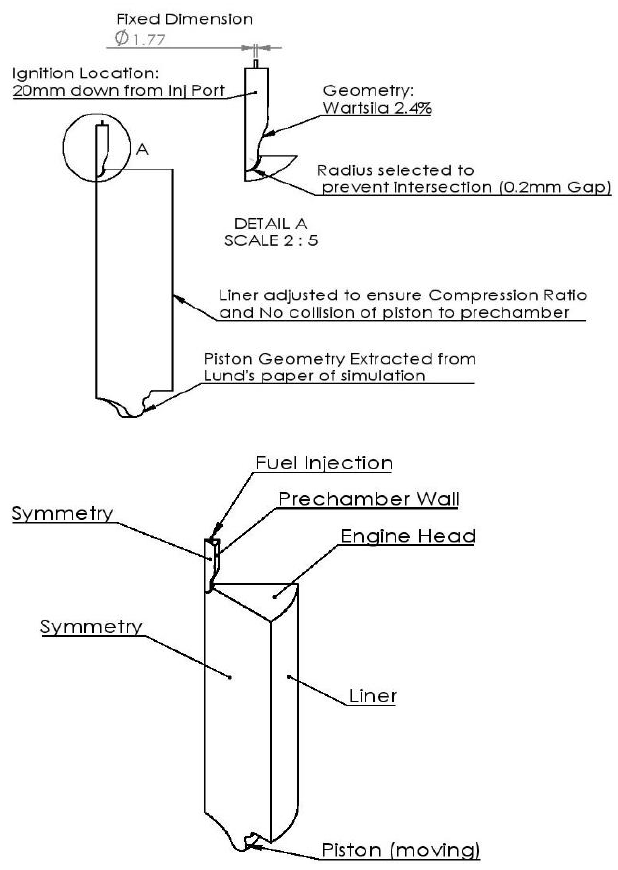
Figure 1. Geometry of the test engine.